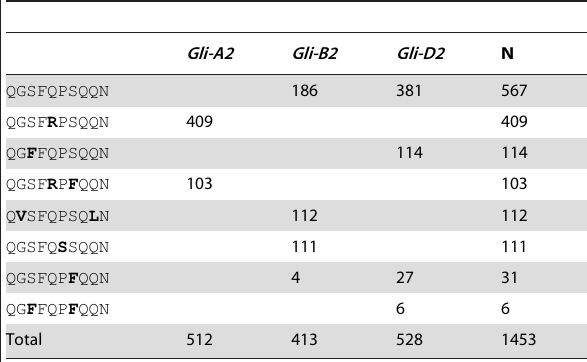
Table 5. DQ8-Glia- a 1 epitope variants expressed in bread